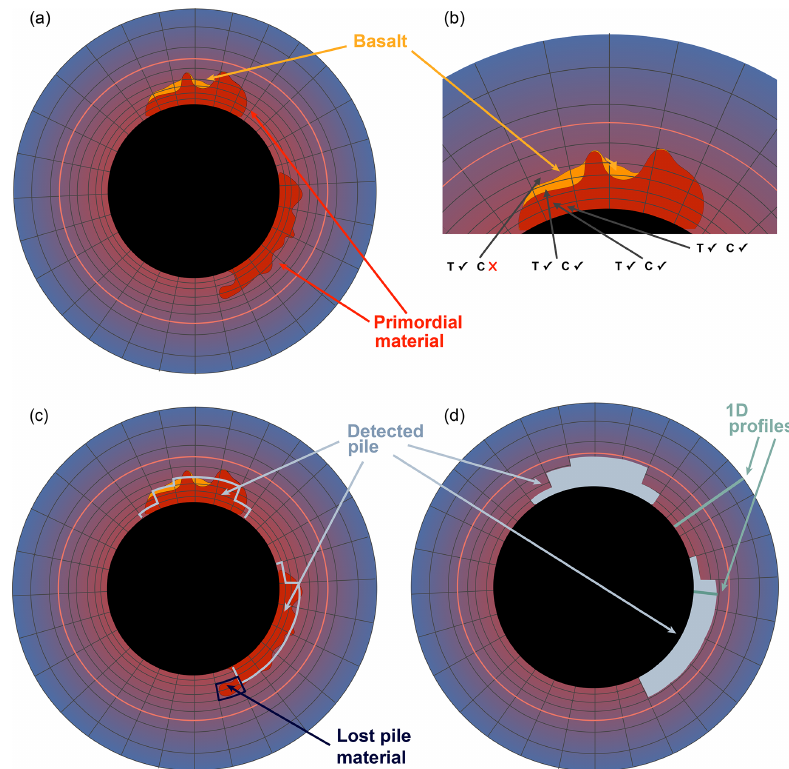
Figure 1. Sketch showing the steps of our pile detection routine: first, we set the criteria; then, we check each cell column starting at the CMB for the criteria and stop the detection if one of the criteria is not any more fulfilled. Finally, we write a new pile field whose characteristics are saved and can be used for further